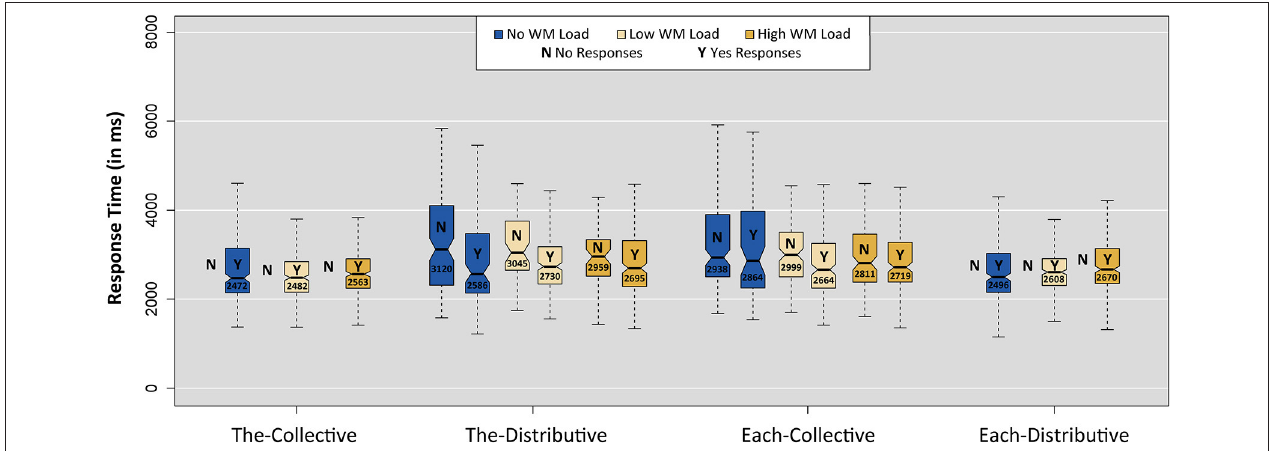
FIGURE 5 | Boxplots of response times per condition and WM load for both “yes” and “no” responses. Notches indicate 95% confidence intervals (Chambers et al., 1983 ). Note that conditions The-Collective and Each-Distributive had too few “no” responses to be plotted (only seven “no” responses in total).